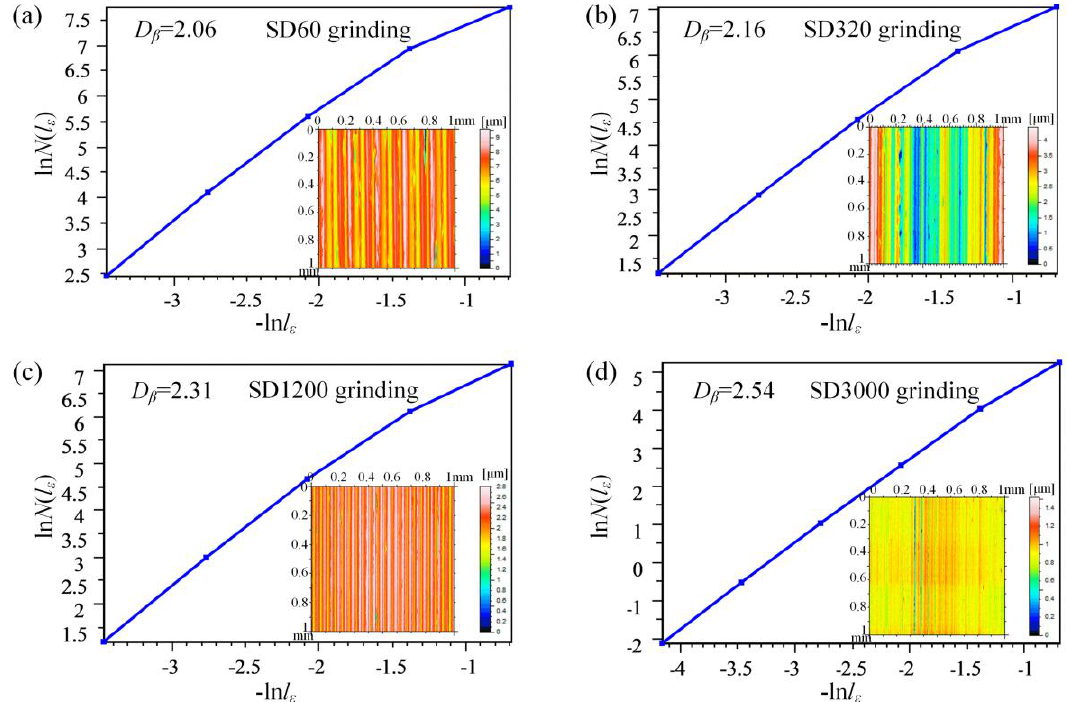
Figure 6. The fractal dimensions of the micromachined BLHS surfaces. The subgraphs are the measured surface topographies.